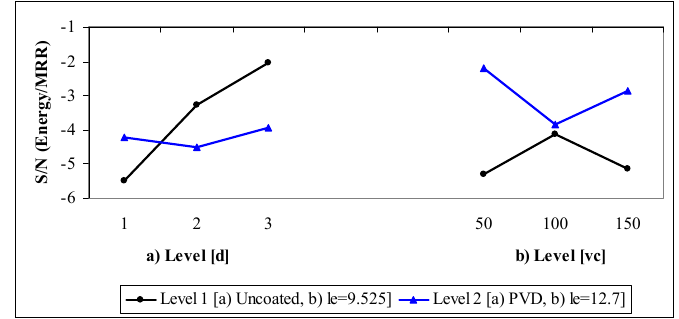
Figure 3. Values of the S/N ratio of the significant interactions for energy/MRR.